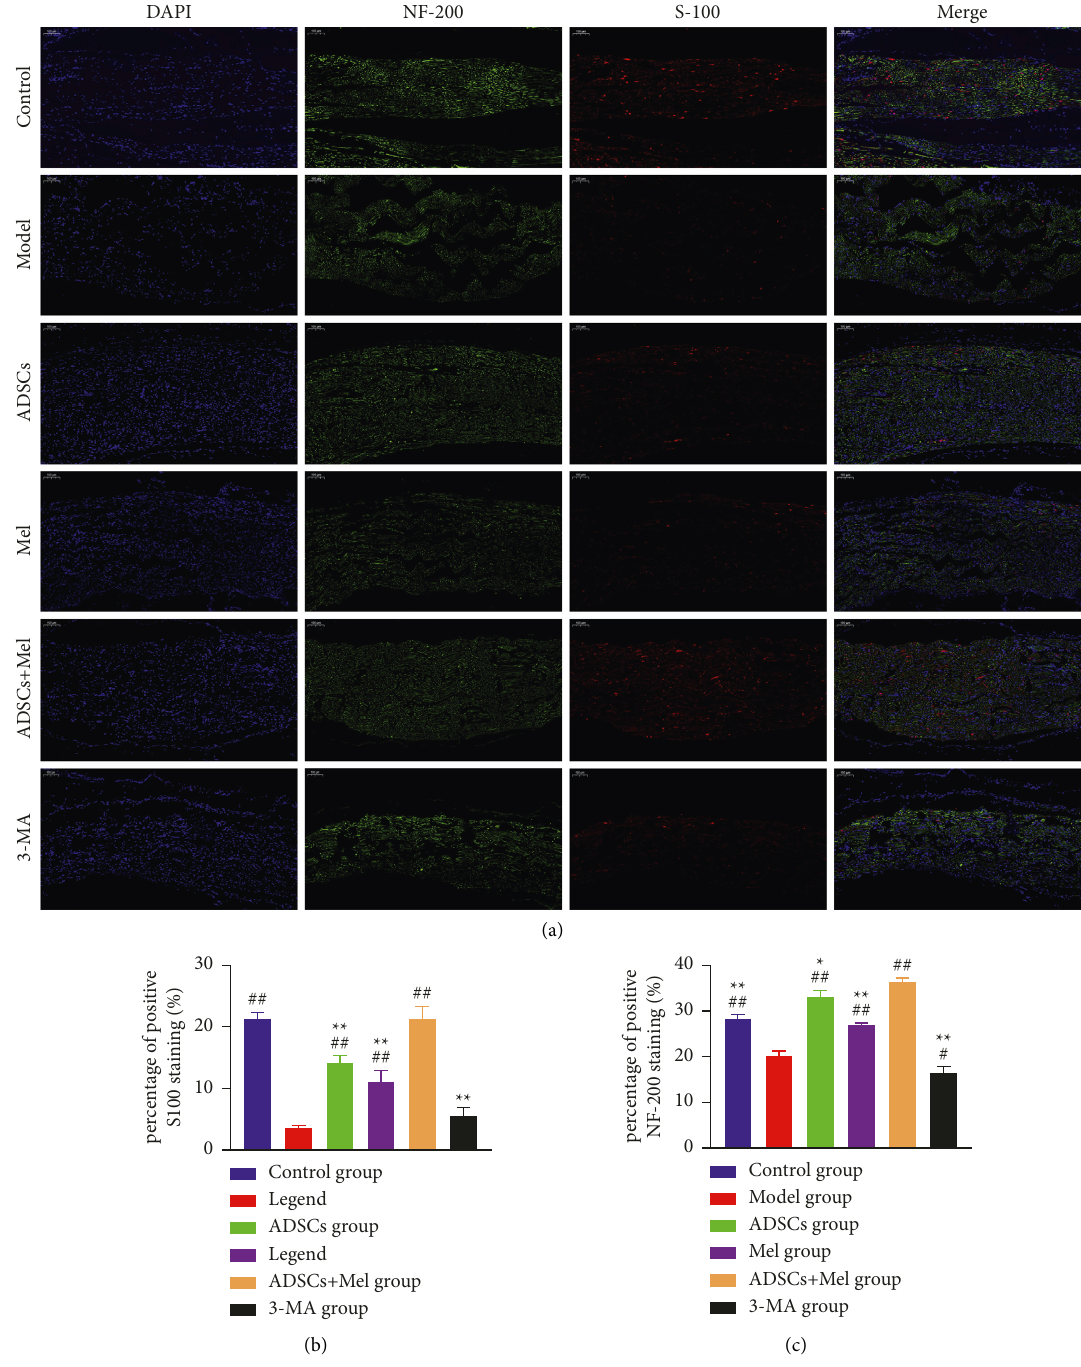
Figure 8: The expression of S-100 and NF-200 was detected by immunocytochemistry. (a) In experimental groups, the fluorescence intensity of NF-200 (green) and S-100 (red) elevated, which was detected by immunocytochemistry. (b)-(c) The fluorescence intensity. The control group, ADSCs group, Mel group, ADSCs+Mel group, and 3-MA group were compared with the model group, respectively. Each value is the mean ± SE of five independent determinations. ## P < 0 . 01 and # p < 0 . 05, compared with the model group; ∗∗ p < 0 . 05, the control group, ADSCs group, model group, Mel group, ADSCs +Mel group, and 3-MA group were compared with the ADSCs+Mel group; scale bar � 100 μ